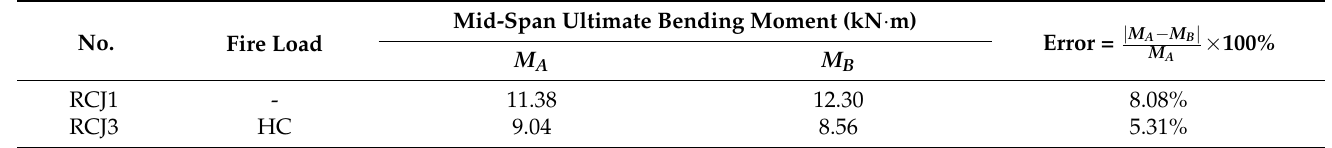
Table 4. Comparison between numerical simulation and experimental results of the tunnel segmental